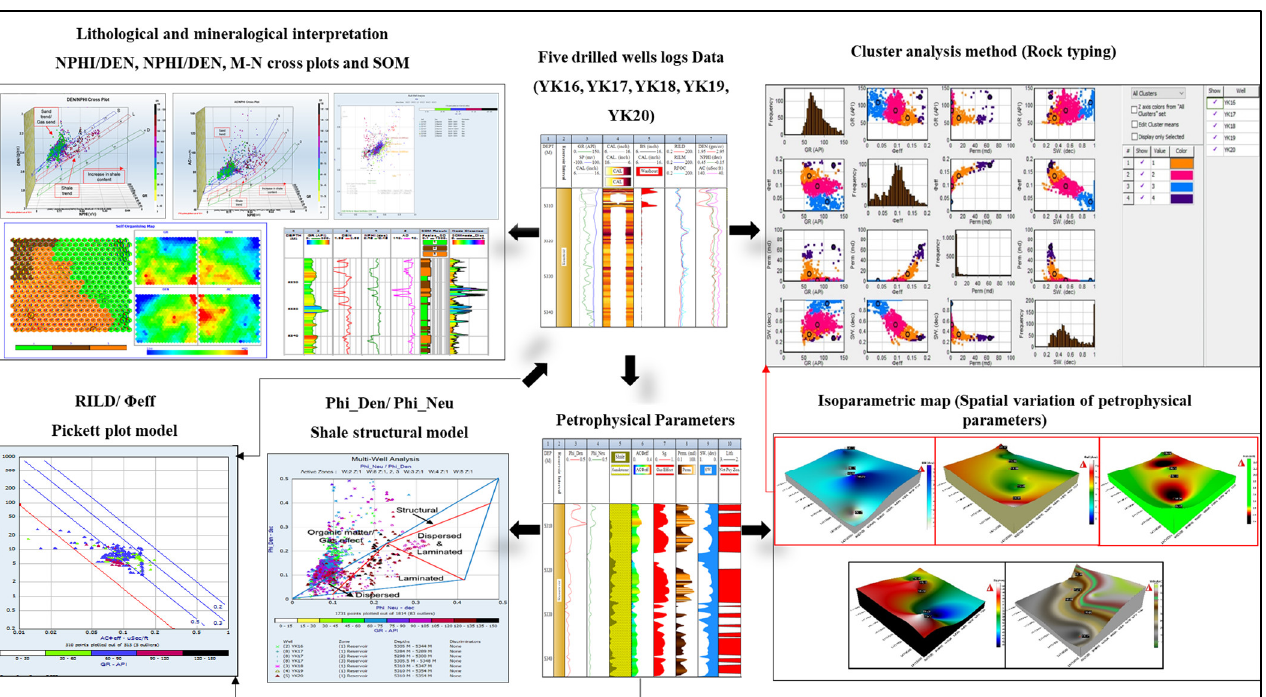
Figure 4. Litho saturation cross plot for YK18.